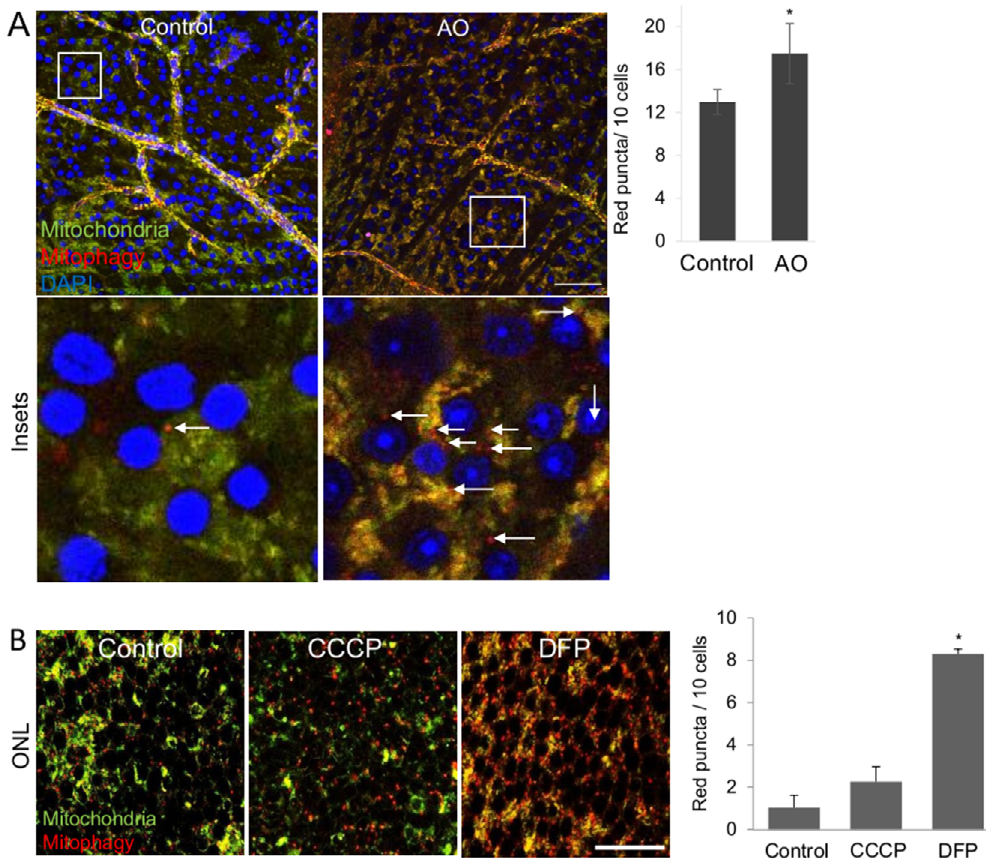
Figure 5. Ex vivo retinal explants as tool for mitophagy assessment. ( A ) Retinal explant cultures treated with antimycin 10 µ M plus oligomycin 1 µ M for 8 h. Graph shows the number of red-only puncta per 10 nuclei in the RGCL, scale bar 25 µ m. ( B ) Retinal explants culture with 10 µ M CCCP and 1mM DFO for 8 h. Graphs show the number of red-only puncta per 10 nuclei in the ONL, scale bar 10 µ m. ONL, Outer nuclear layer; RGCL, retinal ganglion cell layer. * p < 0.05.